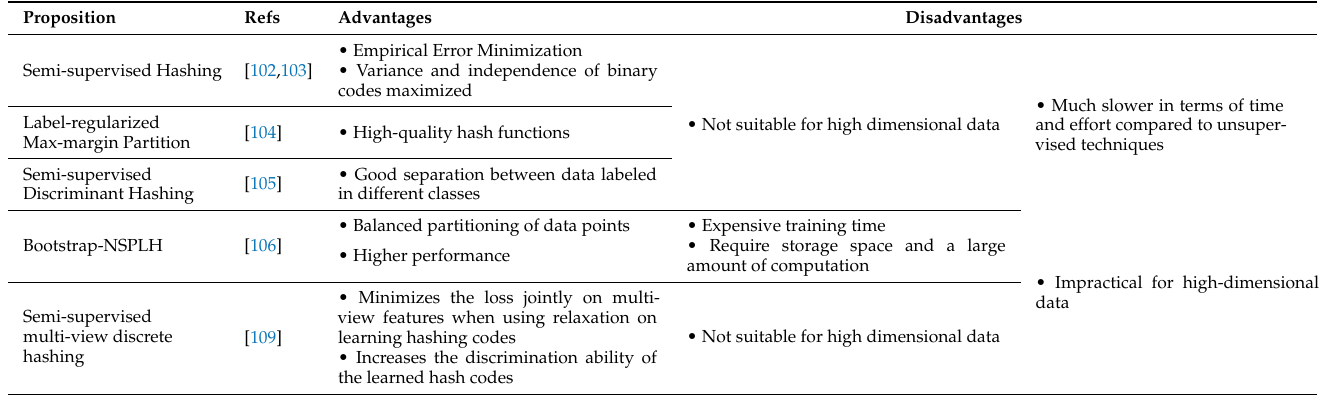
Table 5. Summary of advantage and disadvantage of semi-supervised hashing